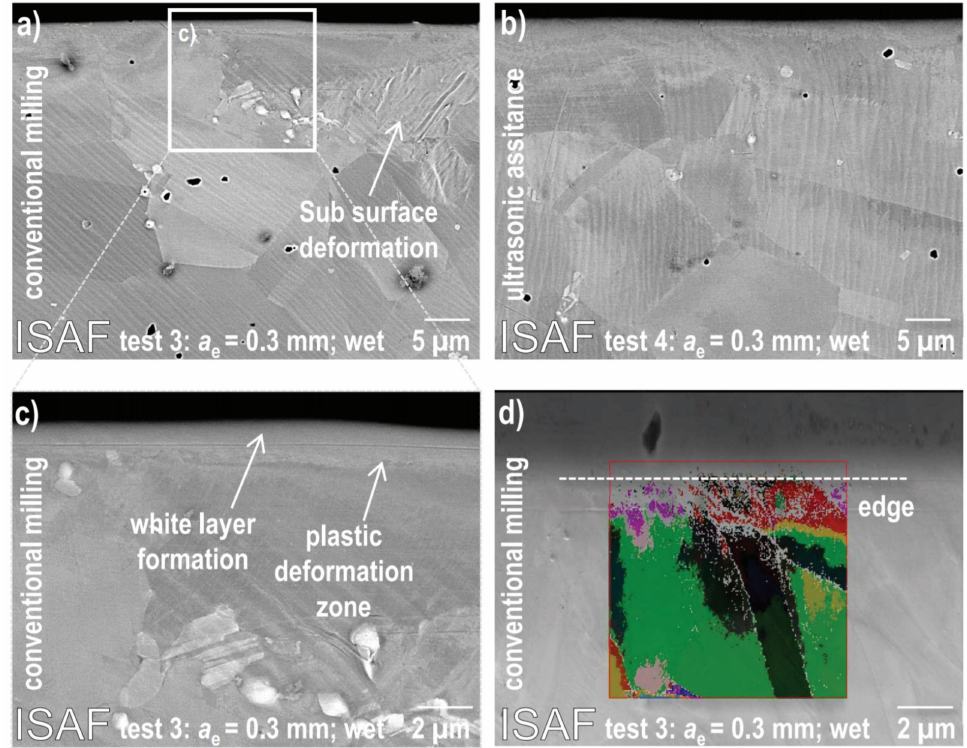
Figure 27. SEM image of cross sections of milled specimens of test 3 ( a ) and test 4 ( b ) and detail of the surface plastic deformation zone and white layer of test 3, showing the SEM analysis ( c ) and EBSD mapping ( d )